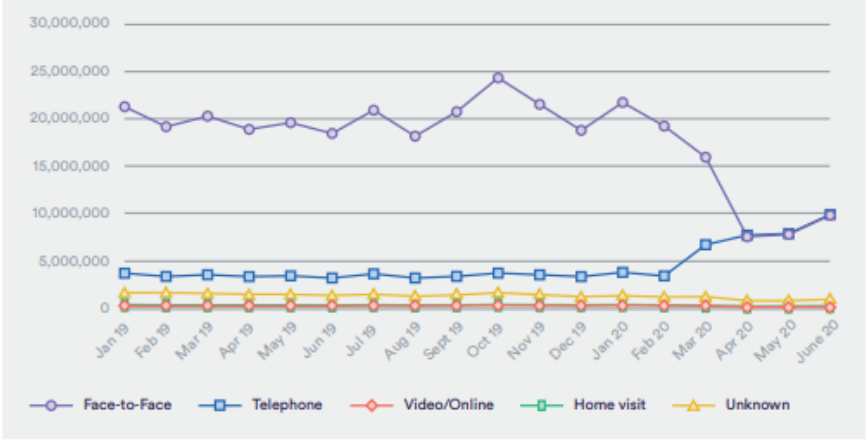
Figure 3. Appointments to the general practitioners from January 2019 to June 2020 (permission to reproduce from Hutchings [31]).